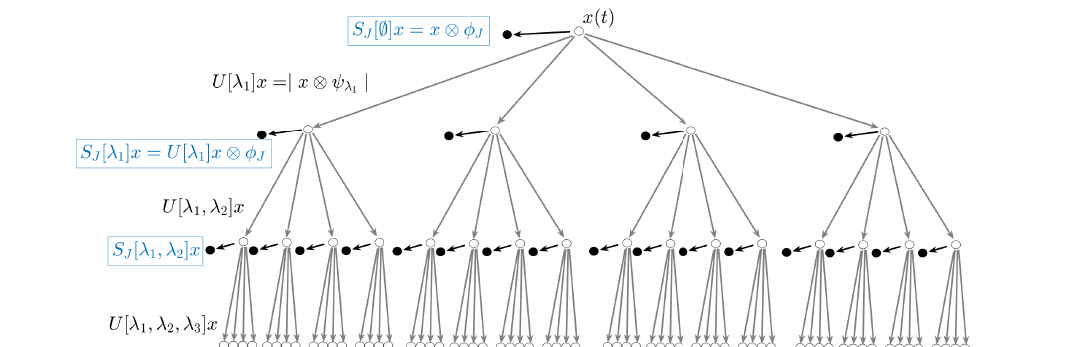
Figure 5. A three layer wavelet scattering network. The operator U λ to calculate each U [ λ 1 ] x and output S J [ ∅ ] x , where ∅ represents an empty set. Then, the operator U λ is applied to each previous layer U [ λ 1 ] x to calculate all U [ λ 1 , λ 2 ] x and output S J [ λ 1 ] x . This scattering process is operated iteratively to obtain all convolution results.